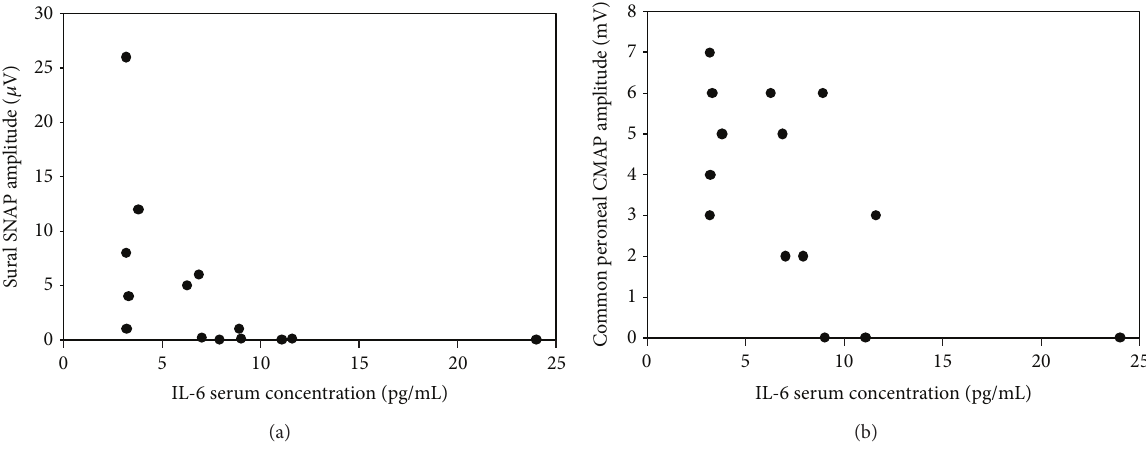
Figure 1: The correlation between the serum concentration of IL-6 and sural nerve sensory nerve action potential (SNAP) amplitude (Spearman’s 𝜌 correlation coefficient = − 0.085, 𝑝 < 0.001 ; panel (a)) and common peroneal nerve compound muscle action potential (CMAP) amplitude (Spearman’s 𝜌 correlation coefficient = − 0.067, 𝑝 = 0.009 ; panel (b)). For both correlations, Spearman’s 𝜌 correlation coefficient turned out to be